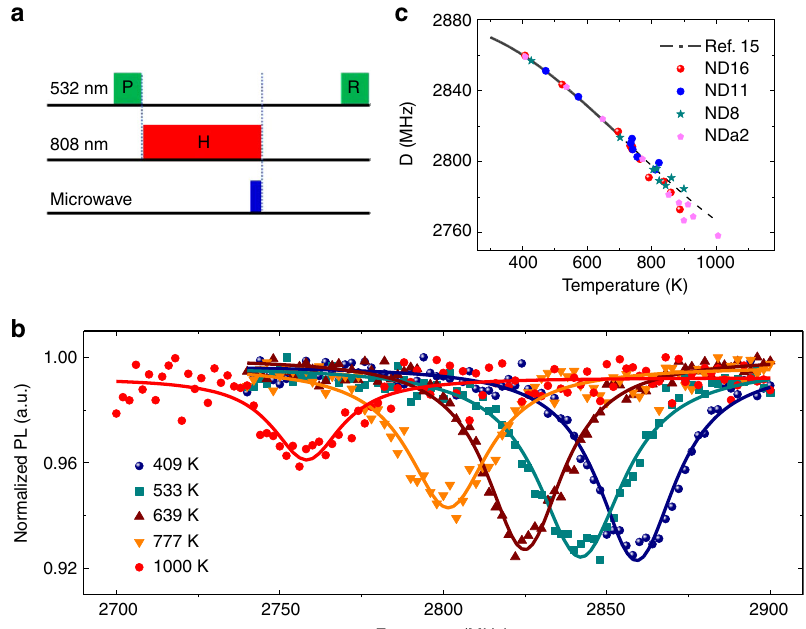
Fig. 2 High-temperature optically detected magnetic resonance (HiT-ODMR) of nitrogen-vacancy (NV) centers in nanodiamonds (NDs). a Pulse sequence for HiT-ODMR, with the same notations as in Fig. 1c. The microwave pulse is applied at the end of the NIR laser pulse. b ODMR spectra of an ND for various heating laser powers (corresponding temperatures indicated, see Methods and Supplementary Note 6 for details). The NIR laser pulse duration τ h is fi xed to be 5 μ s. The stationary temperature is proportional to the NIR laser power. c The temperature dependence of the zero- fi eld splitting (ZFS) D ( T ) obtained by extrapolation of the exponential cooling dynamics for four different NDs (indicated by different symbols), in comparison with the results from ref. 15 (solid line for T < 700 K). The dashed line is the fi tting formula in ref. 15 extended to 1000